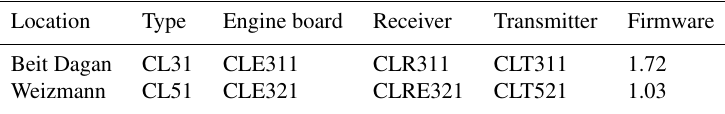
Table 4. Ceilometer technical